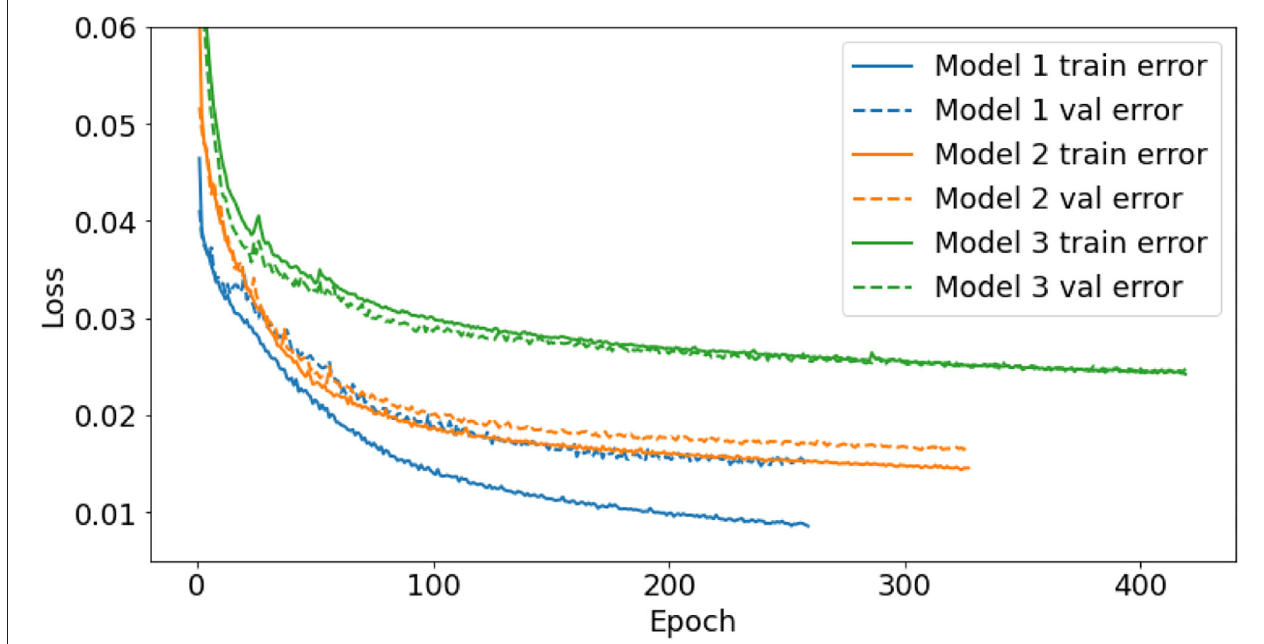
FIGURE 9 | Training history of the three models used to fill temperature gaps. Model 1 (blue) fills gaps up to 6 days long, model 2 (orange) fills fill gaps 6–30 days long, and model 3 (green) fills the remaining 2 gaps, 79 and 91 days long. Both the training (solid) and validation (dashed) losses are shown. An epoch is a single pass through all training